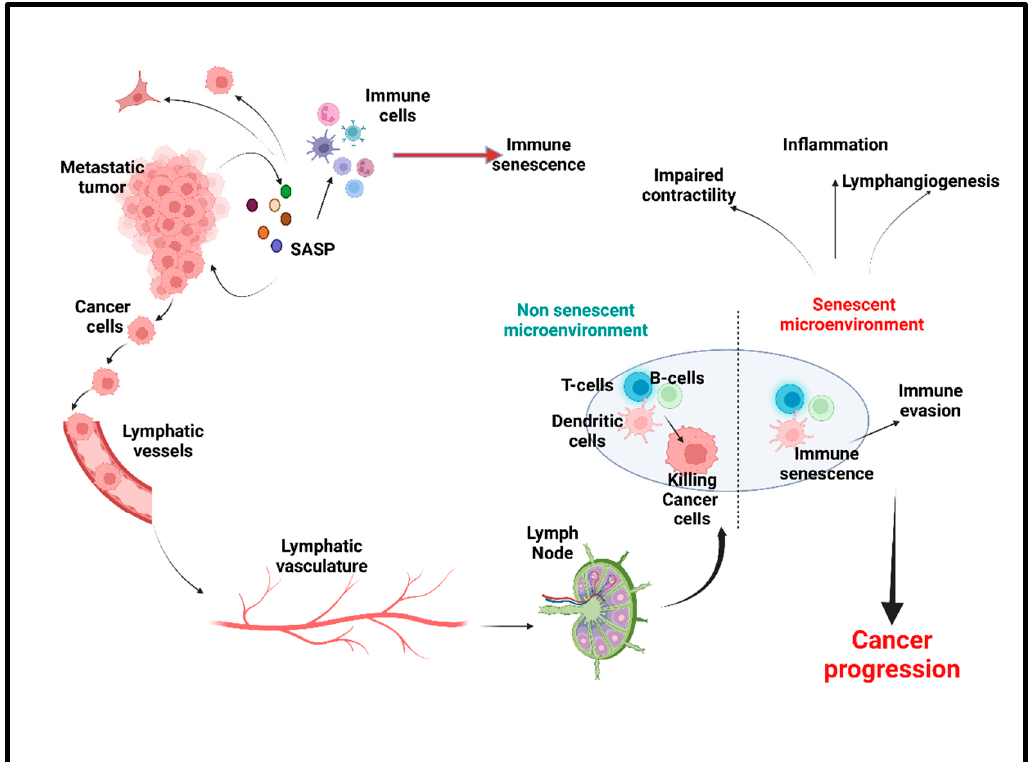
Figure 5. Immunosenescence in cancer microenvironment and immune evasion in lymph node Senescence-induced immunosuppression causes the immune evasion of cancer cells in lymphatic system, especially in tumor-draining lymph node (LN). In healthy, young lymph nodes, naïve T-cells enter the LN, compartmentalize, and mature. Upon interaction with the antigen-presenting cells, DCs, the T-cells get activated and help with the B-cell mediated immune response and help with tumor-cell killing. In the aged LN, or prematurely senescent LN, the T-cells become senescent and express the immune evasion markers including PD-1 and TIM3 and the compartmentalization and maturation of B-cells are disrupted. Consequently, the T-mediated tumor-cells killing is disrupted. The senescent lymphatic system is presented with impaired contractility and enhanced inflammation, which also increased the lymphangiogenesis in the tumor-bearing beds. LN: lymph nodes, DC: dendritic